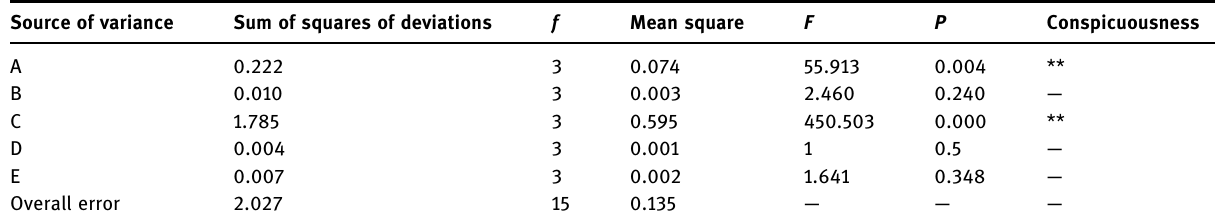
Table 6: Variance analysis of the surface roughness Source of variance Sum of squares of